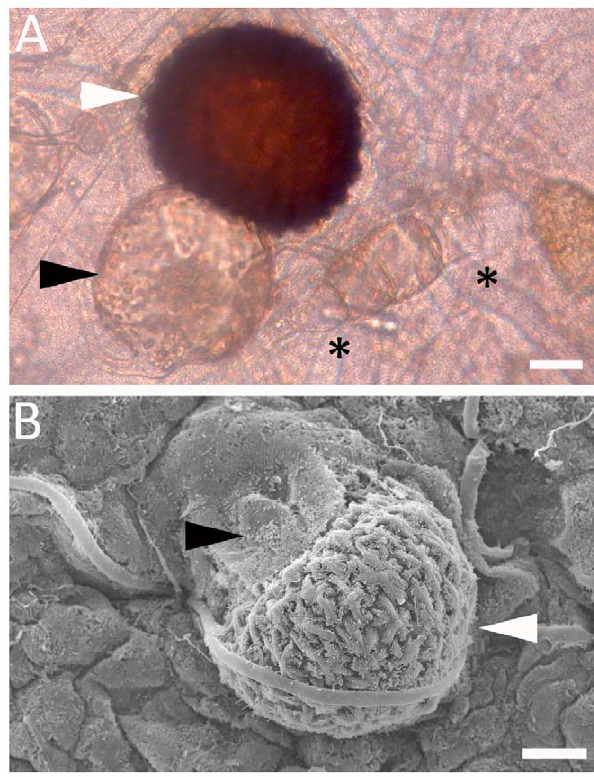
Figure 1. Zygospores of Rhizopus oryzae . A cross between CBS346.36 ( + ) and CBS110.17 ( 2 ) was analyzed with light microscopy (A) and scanning electron microscopy (B). Zygospores (white arrow heads) are attached to an asymmetric suspensor (black arrow heads). Scale=20 m m. Asterisks indicate conjugated hyphae during early stage of zygospore formation.